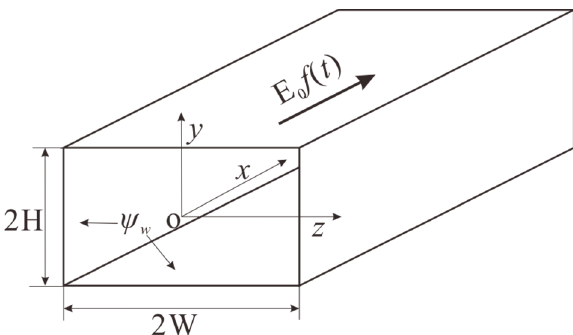
Figure 1. Electroosmotic flow system in a rectangular microchannel. The width of the channel is 2 W and the depth of the channel is 2 H . All the walls are uniformly charged with a zeta potential ψ w , and the dynamic electric field E 0 f ( t ) is applied along the axial direction of the microchannel. The zeta potential on the walls induces a near-wall electric double layer (EDL) which has a non-zero charge density. Then, interaction of the external electric field with the non-zero charge density induces a driving force for electroosmosis.